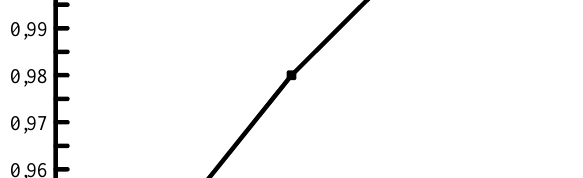
Figure. 12. Schedule changes in the probability of correct recognition of individual flat objects in each of the 55 complex objects with different number of reference